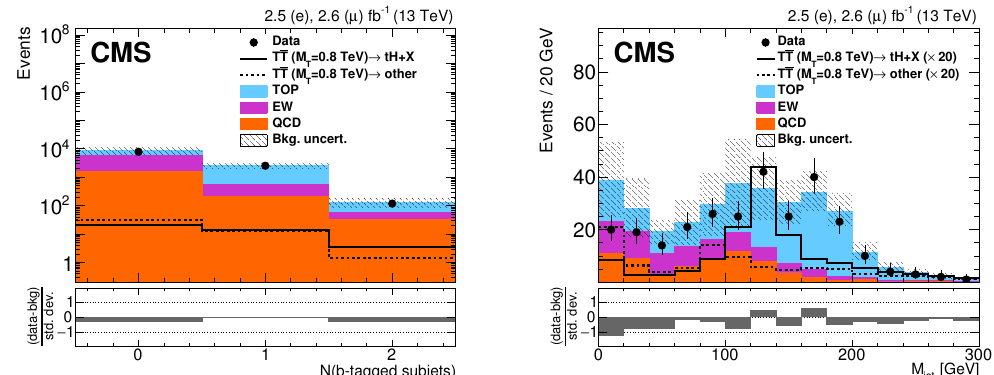
Figure 3 . Distributions of the number of b-tagged subjets of the highest p T H-tagged jet candidate with p T > 300 GeV and M jet in the range [60, 160] GeV (left), and M jet of the highest p T H-tagged jet candidate with p T > 300 GeV and two subjet b tags (right). A T quark signal with M(T) = 0.8 TeV is shown (right), normalized to the predicted cross section and scaled by a factor of 20, with the singlet benchmark branching fractions assumed. The solid (dashed) curve shows TT events with at least one (zero) Higgs boson decay, where contributions from each decay mode are weighted to re(cid:13)ect the singlet branching fraction scenario. The uncertainty in the background includes the statistical and systematic uncertainties described in section